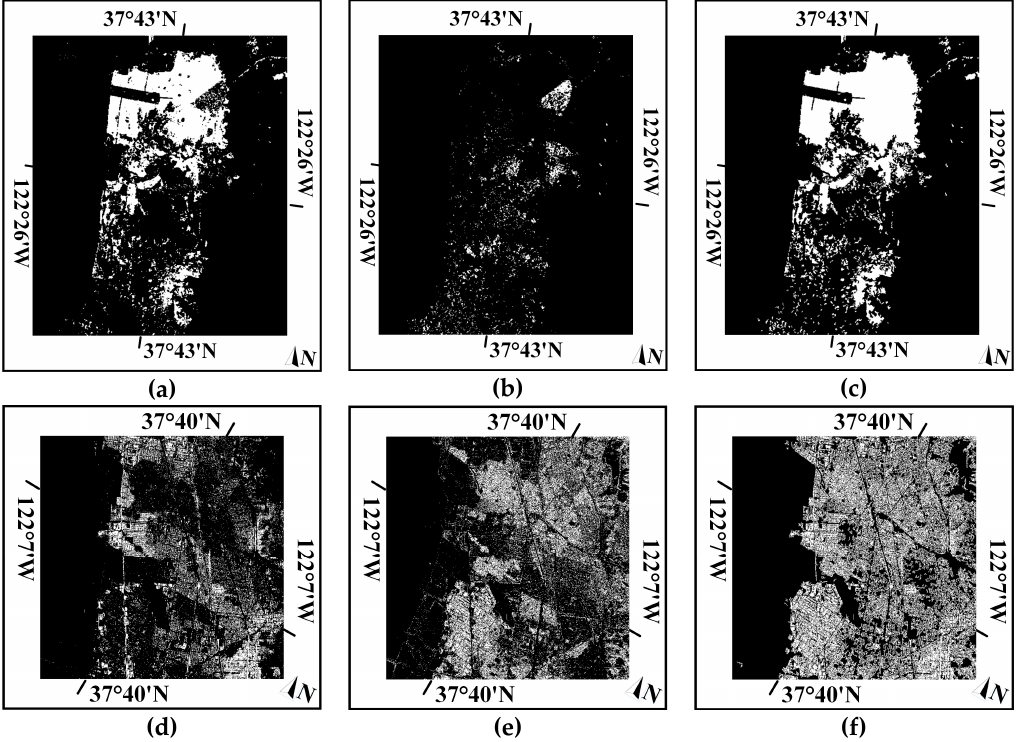
Figure 3. Extraction results using the double-bounce and OOB scattering powers. ( a )–( c ) Extraction of buildings approximately aligned with the flight trajectory (AABs), OOBs, and built-up areas for GF-3 data, respectively. ( d )–( f ) Extraction of AABs, OOBs, and built-up areas for UAVSAR data, respectively.